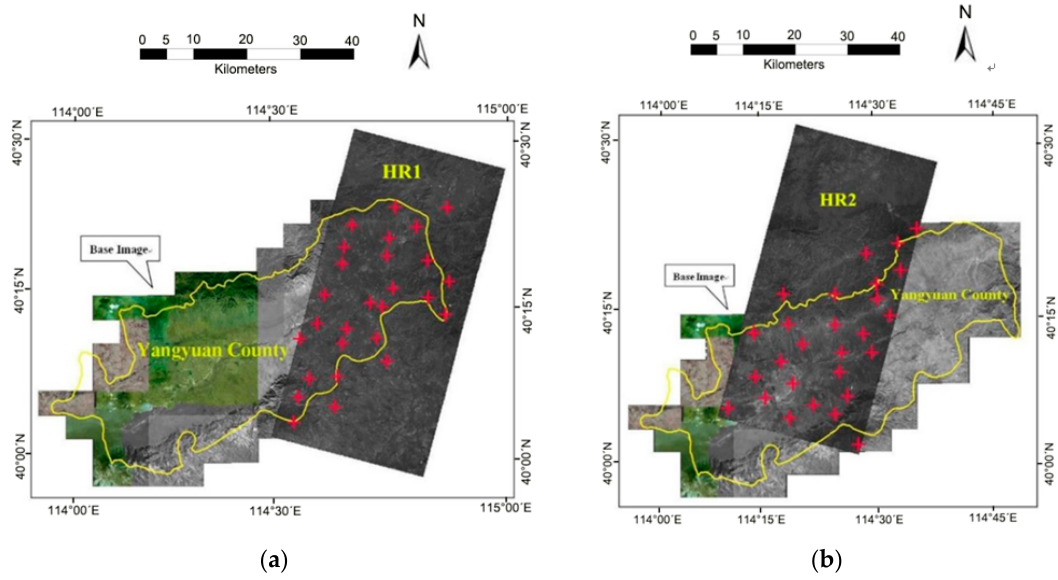
Figure 3. The spatial distribution of the rectification GCPs located on the base image: ( a ) the rectification GCPs were used for rectifying image HR1; ( b ) the rectification GCPs were used for rectifying image HR2.